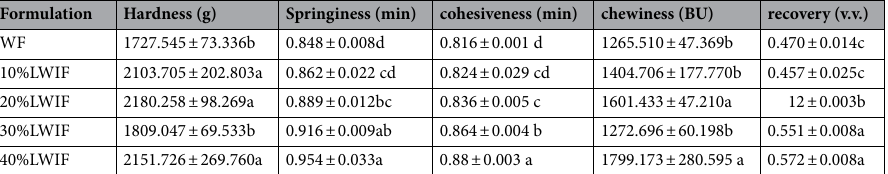
Table 2. Texture of fresh steamed bread prepared from WF and LWIF. Data are mean values ± standard errors of three replicates. Mean values followed by the different letter in the same row are significantly difference ( P < 0.05).